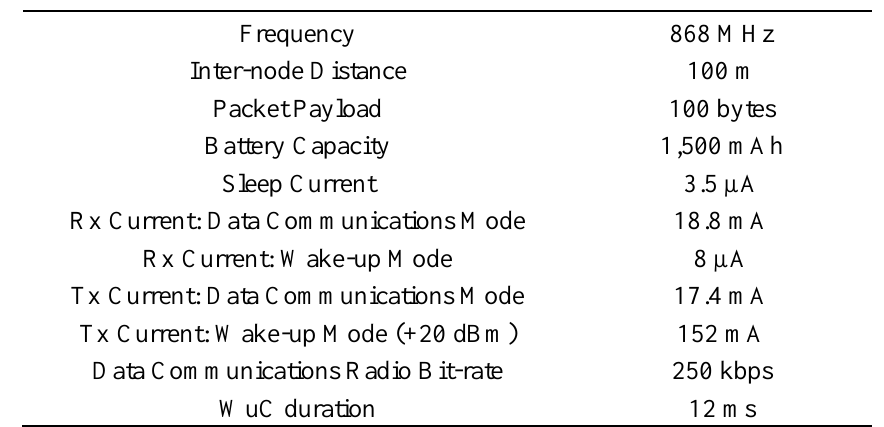
Table 2. SCM-WuR OMNET++ simulation parameter